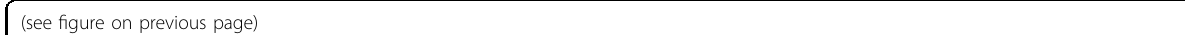
Fig. 4 SARS-CoV-2 GFP/ Δ N infection in EIIA-hACE2-N F/F mice. a EIIA-hACE2-N F/F mice were intranasally challenged with 1 × 10 5 TCID 50 virus each and sacri fi ced to collect tissue samples at 7 dpi. b Pathological changes in lungs of EIIA-hACE2-NF/F mice after infection. Five euthanized mice were used to examine the pathological changes in the lungs at 7 dpi. c Immuno fl uorescence staining of mouse lung paraf fi n sections against the SARS- CoV-2 GFP/ Δ N GFP protein (green), N-HA (red), and DAPI (blue). d Tissue distribution of SARS-CoV-2 viral RNA (the GFP gene RNA) level which relative to the Sftpc-hACE2-N mouse lung tissue group. Each tissue was processed with viral RNA copies analysis by real-time qPCR. e , f Immuno fl uorescence staining of mouse intestine ( e ) and stomach ( f ) paraf fi n sections for SARS-CoV-2 GFP/ Δ N GFP protein (green) and DAPI